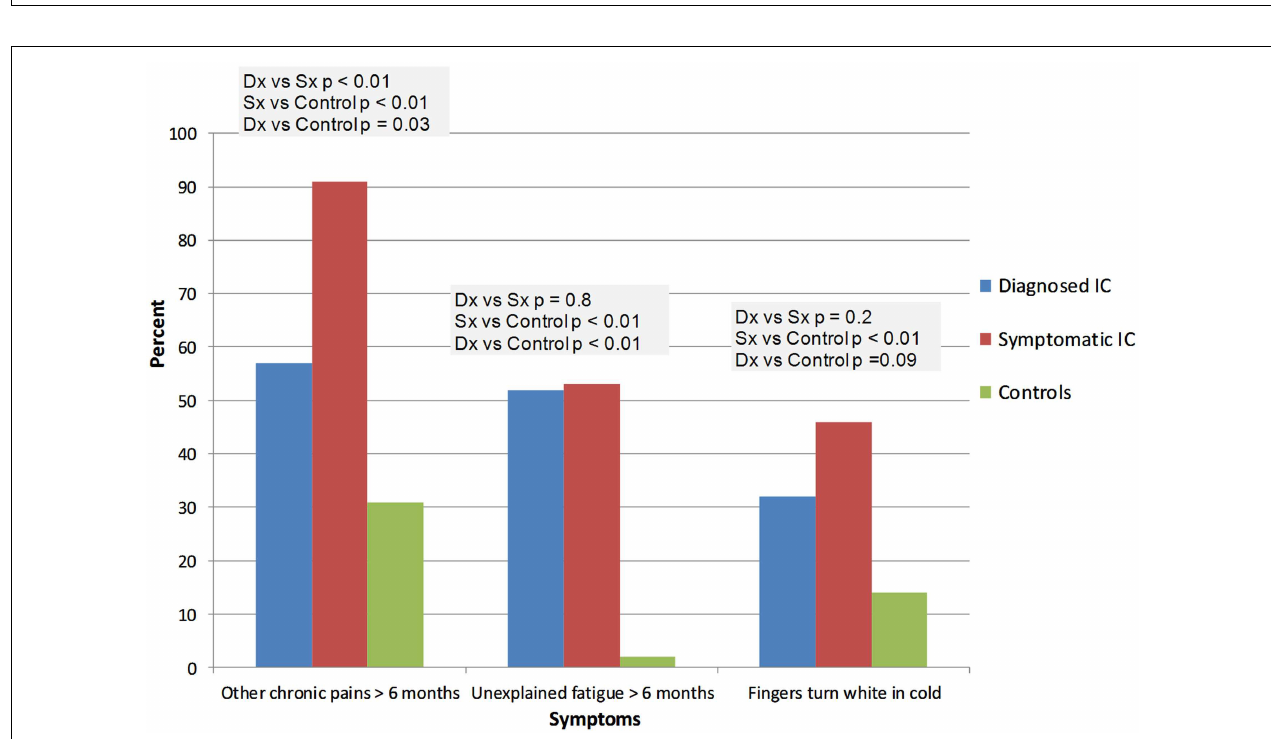
FIGURE 1 | Comparison of effects of IC/BPS on sleep function between healthy controls and patients diagnosed by physician or questionnaire. Dx: corresponds to IC/BPS